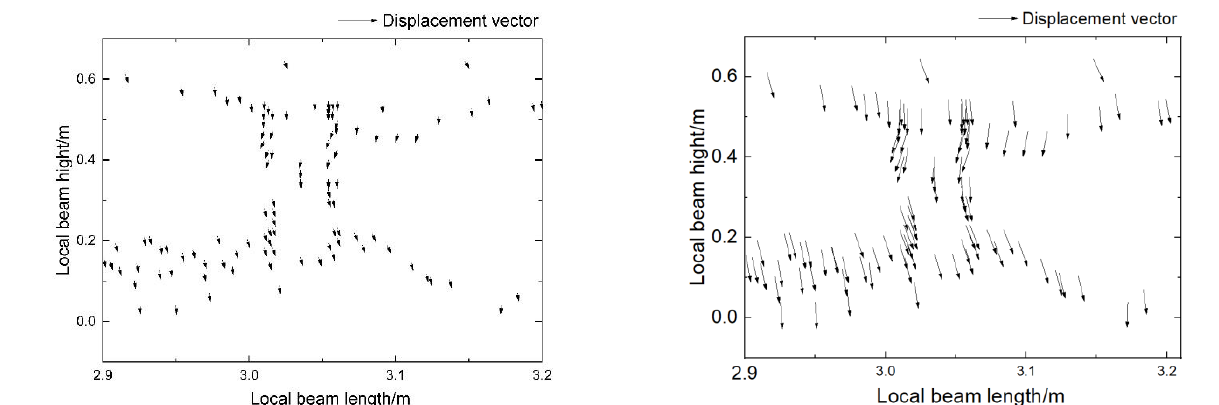
Figure 25. Displacement vector distribution of nos. 13 – 14 damaged member under condition D01.